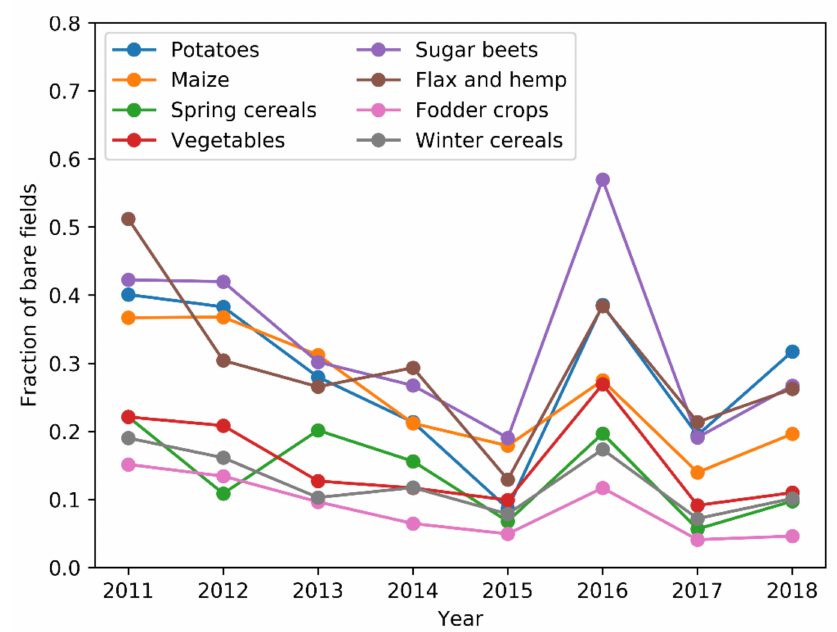
Figure 5. Evolution of fraction of bare fields in winter (November–January) attributed to the main summer cultivation for all major crop groups in Flanders. Note that the dry 2016 winter resulted in very low NDVI values and a potential under-detection of covered fields. (Data source: Land- sat